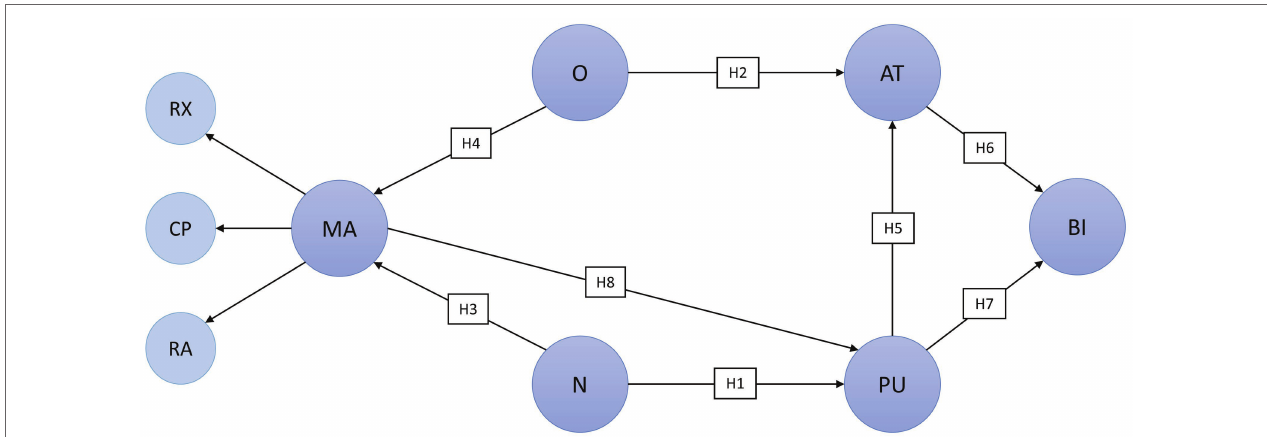
FIGURE 2 | Research model and hypotheses. AT, attitude toward using MSS; BI, intention to use MSS; CP, cognitive problem solving; MA, modulation of negative affect through music; N, neuroticism; O, openness; PU, perceived usefulness of MSS; RA, reduction of negative activation; and RX,